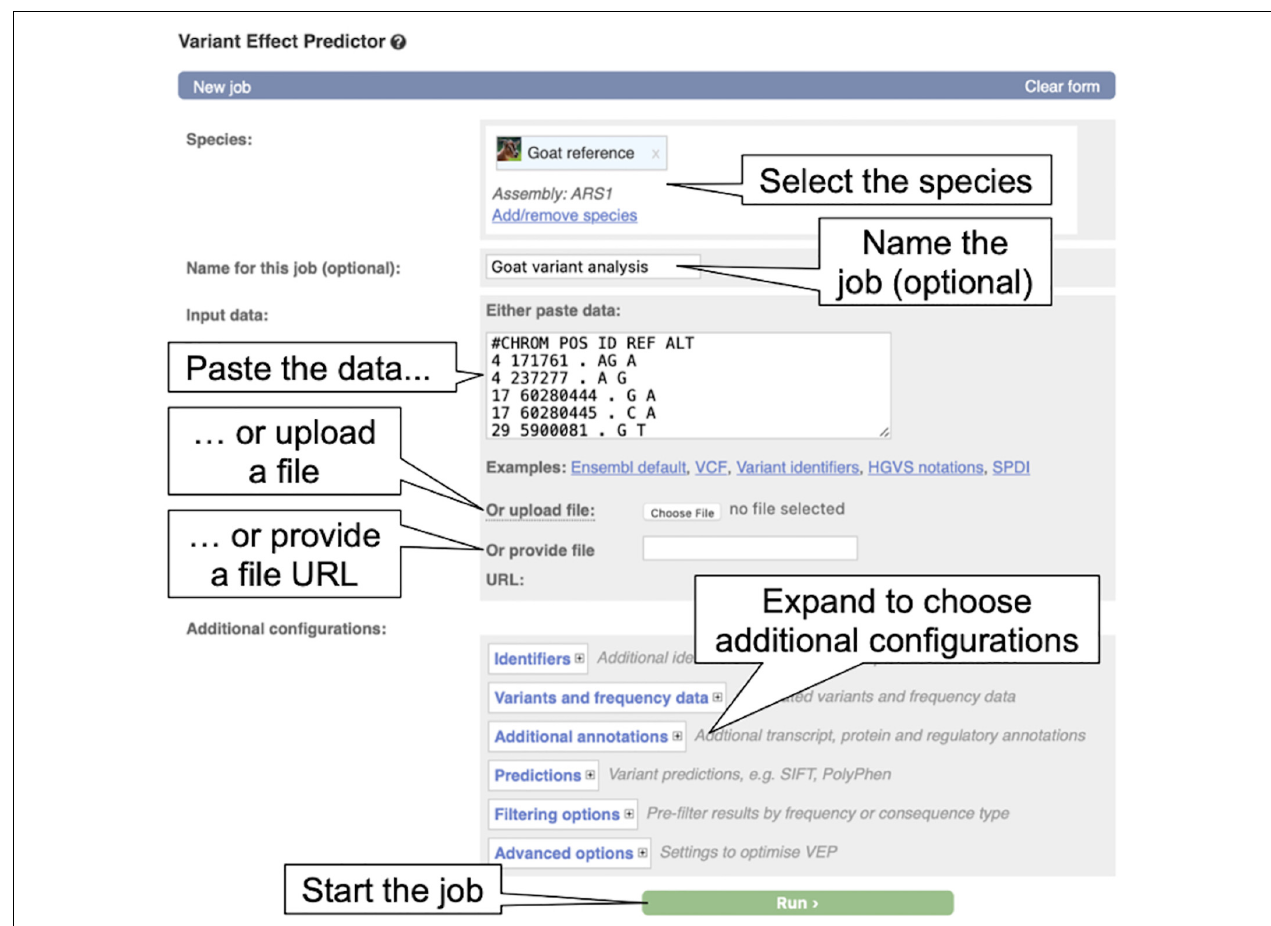
FIGURE 7 | The Variant Effect Predictor input form. The overlayed dialogue boxes provide a breakdown of the steps involved in submitting data to the